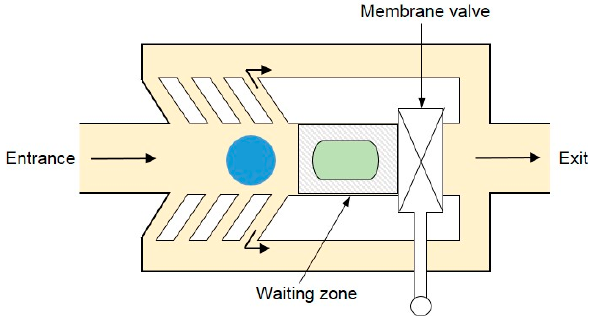
Figure 19. Schematic illustration of the pneumatically actuated droplet coalescence.